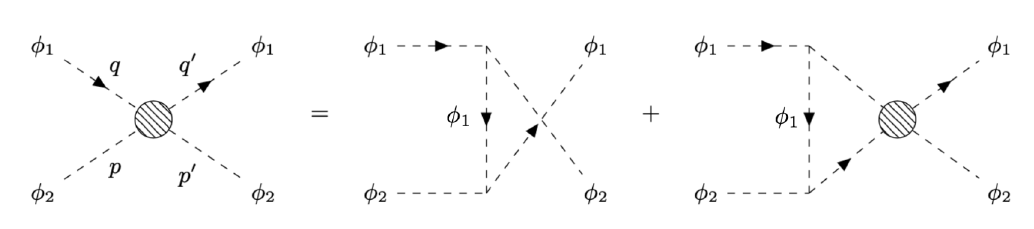
Figure 1 . Feynman diagrams for φ 1 φ 2 → φ 1 φ 2 at the non-perturbative